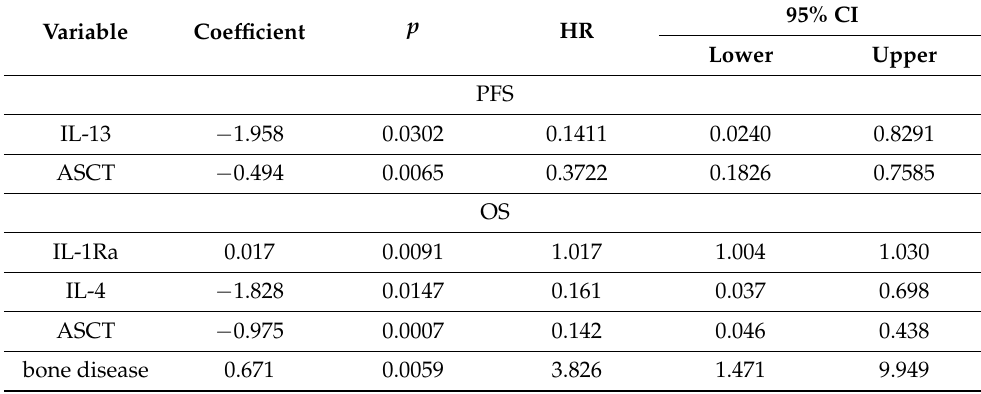
Table 4. Final multivariate Cox regression analyses for PFS and OS of MM patients. Cytokine concentrations (pq/mL) were divided by 10 to allow a more straightforward interpretation of coef- ficient values.